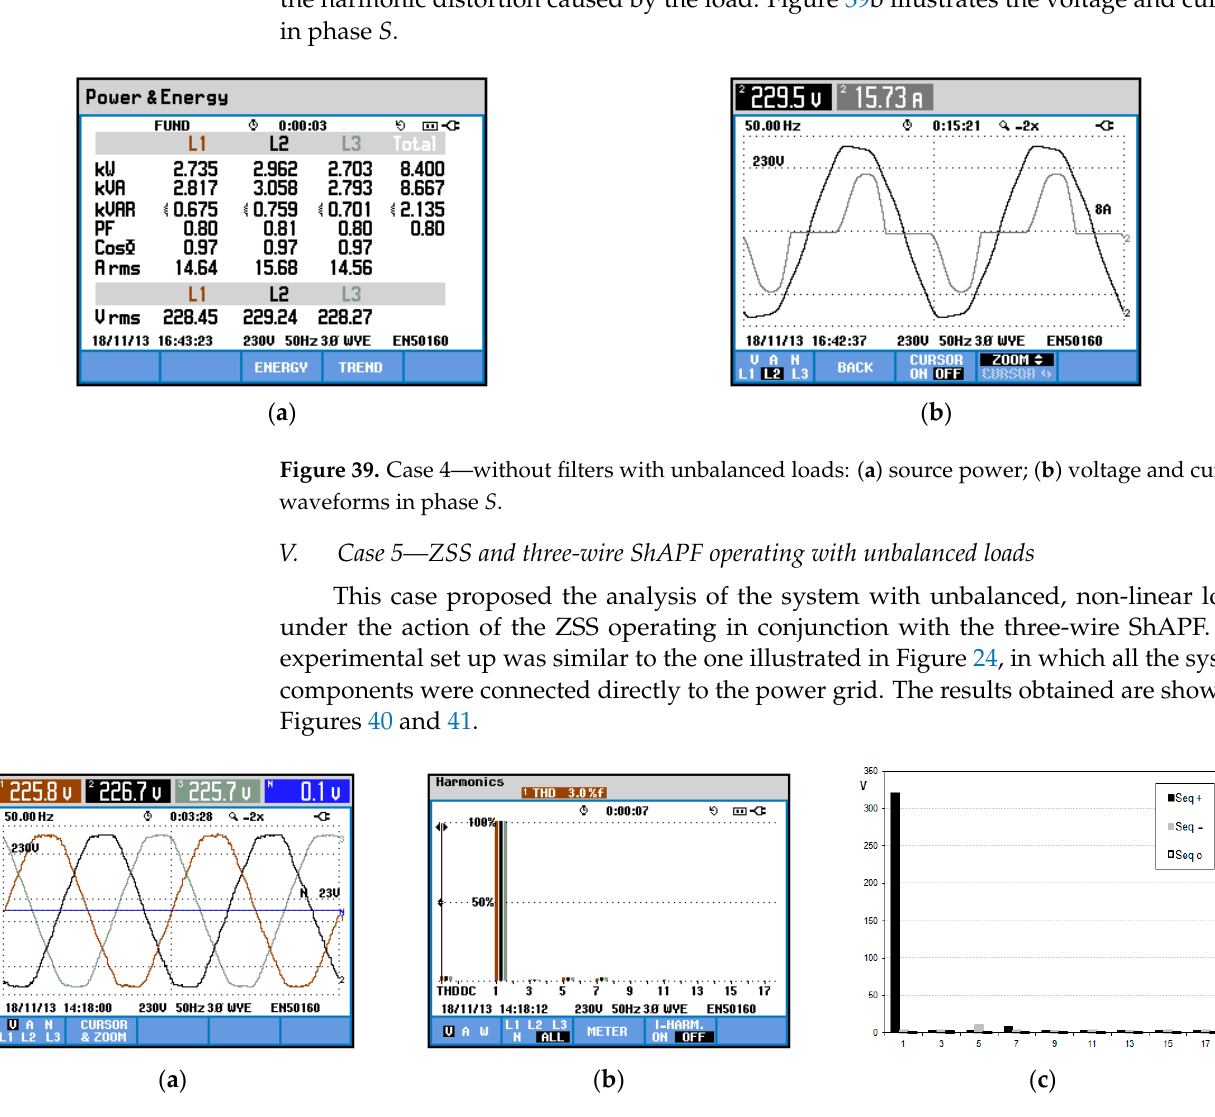
Figure 41. Case 5 - ZSS and three-wire ShAPF operating with unbalanced loads: ( a ) three-phase currents; ( b ) harmonic spectrum of the currents; ( c ) harmonic spectrum of the current sequence components (maximum values).